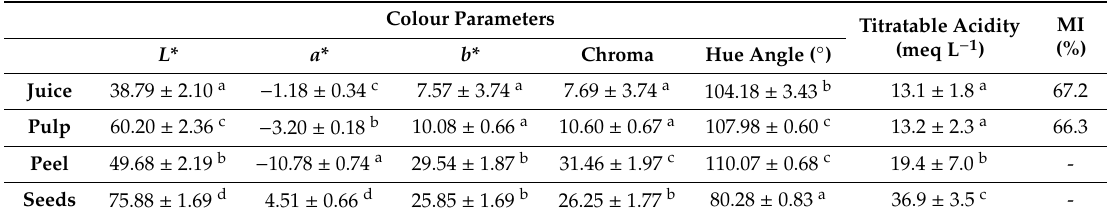
Table 1. Colour parameters, titratable acidity and maturity index (MI) of edible and non-edible melon parts. Results are displayed as mean ± margin of 95% confidence interval †